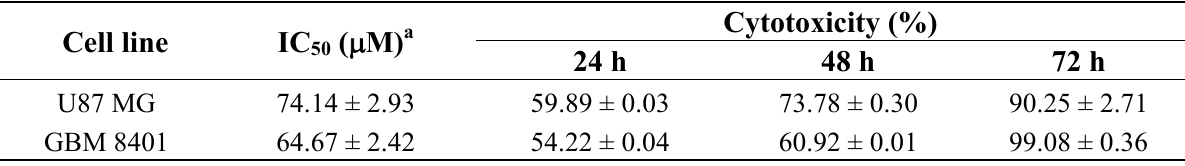
Table 2. The time dependent cytotoxicity of γ -mangostin in human glioblastoma cells. Brain cancer cells treated for different times (24, 48 and 72 hours) with IC γ -mangostin. Cell cytotoxicity was analyzed by MTT